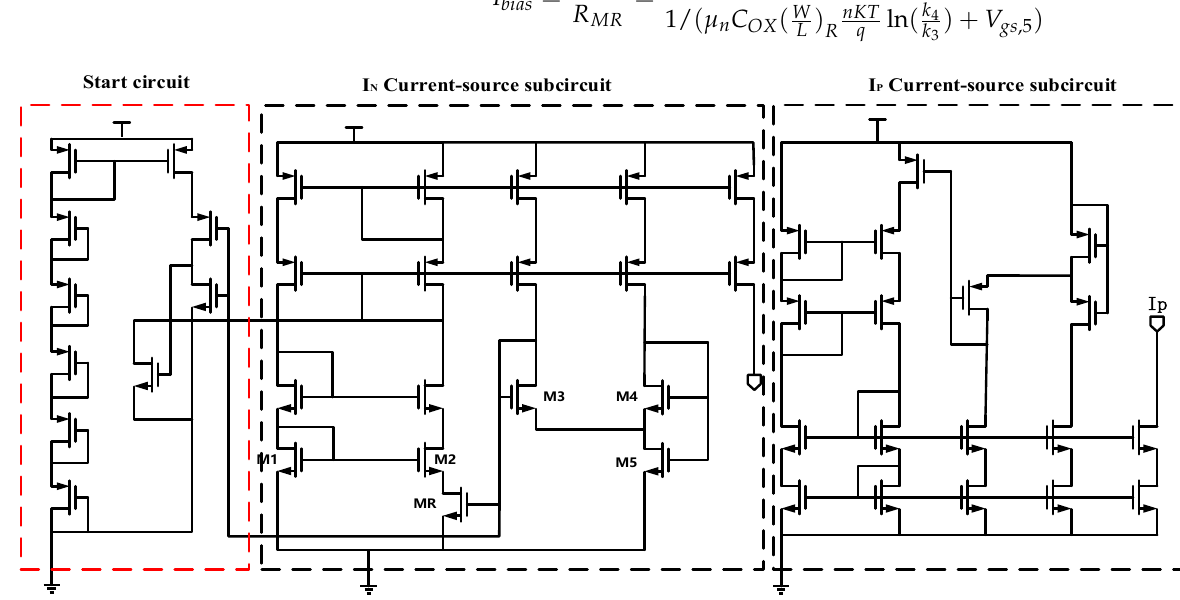
Figure 10. Schematic of Nano-ampere current